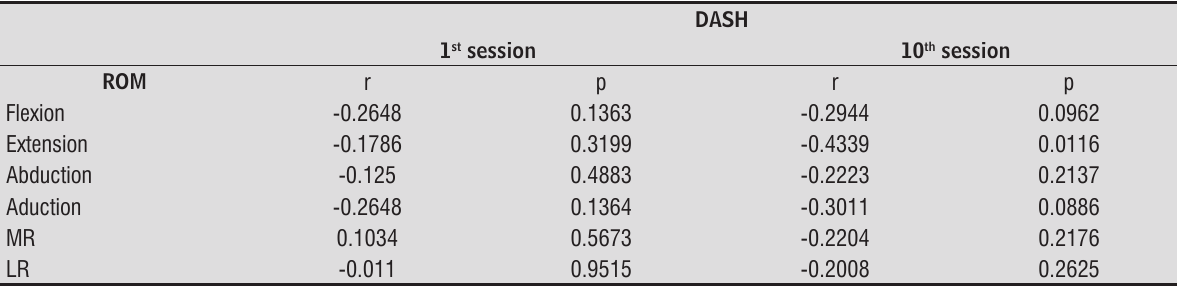
Figure 1 - Comparison of DASH score after 1st session and 10th session of physiotherapy (n = 33); *p= 0,001; T- Student Table 4 - Correlation between DASH score and ROM of homolateral UL to surgery at 1st session and 10th session of physio- therapy DASH